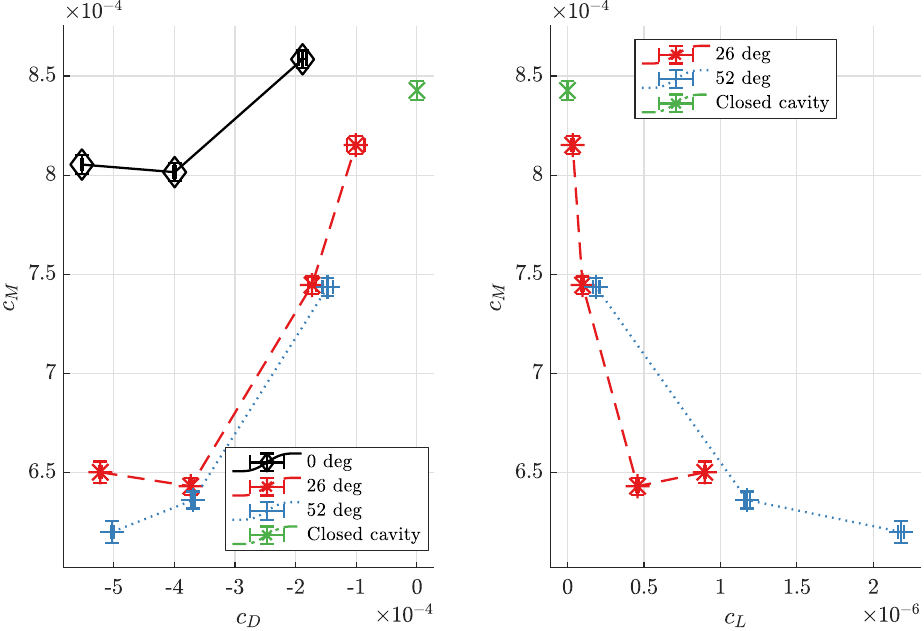
Figure 6. Torque coefficients c M measured at the relative gap width of G = 0.0125 and in the Reynolds number range of 1.8 10 8 2.9 10 8 : The closed cavity configuration is compared to centripetal Re × ≤ ≤ × through-flow at three different preswirl